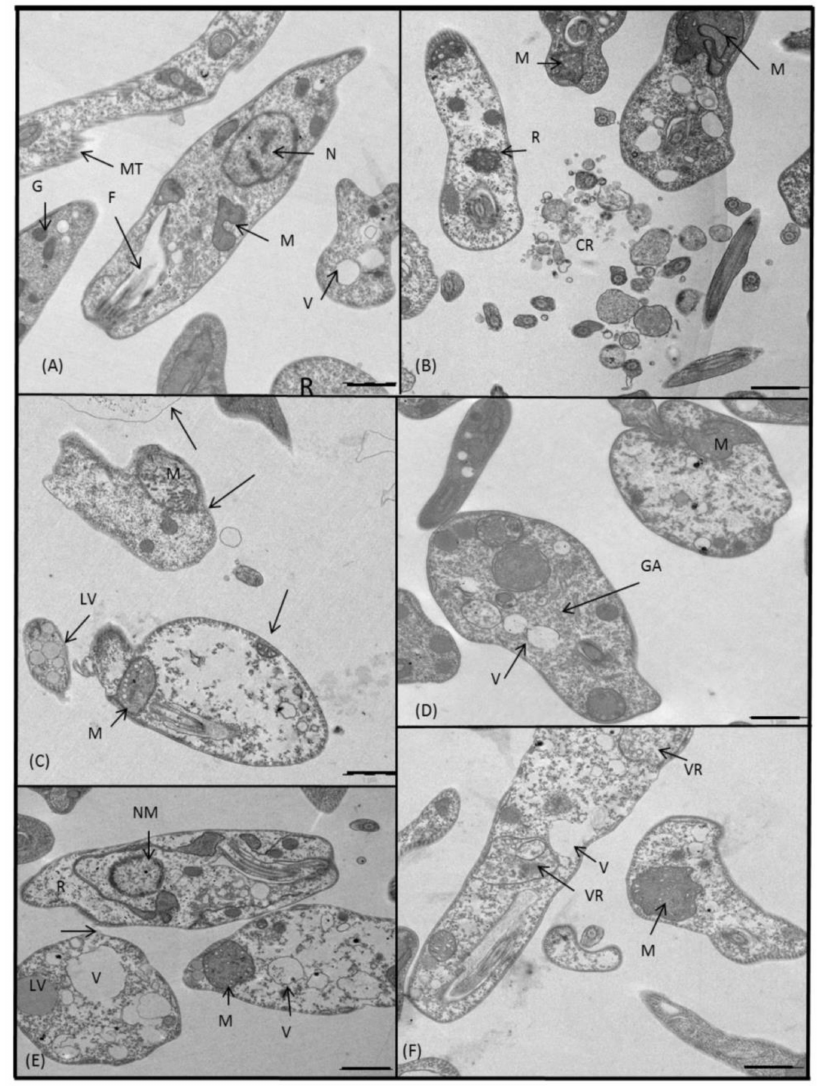
Figure 8. Ultrastructural images of L. donovani promastigotes treated for 72 h at IC 25 concentrations with: ( A ) untreated control, ( B ) 6 , ( C ) 7 , ( D ) 8 , ( E ) 10 , ( F ) 5 . (N) nucleus, (NM) nuclear membrane, (M) mitochondrion, (F) flagellum, (R) ribosomes, (MT) microtubule, (GA) Golgi apparatus, (G) glycosome, (CR) cellular rest, (V) vacuole, (LV) lipid vacuole, (VR) vacuole full of rests, (arrow) dead promastigote. In all cases scale bar corresponds to 1 µ